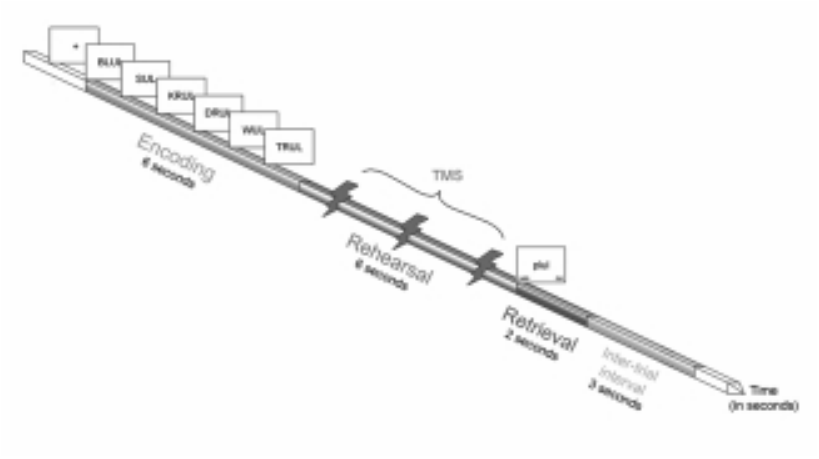
Fig. 2. Schematic of a TMS trial, The Sternberg VWM paradigm [28] has three phases: encoding, maintenance and retrieval. During the encoding phase, subjects studied a list of 6 short phonologically similar (depicted here) or phonologically dissimilar pseudo-words presented at a rate of 1 item per second. During the rehearsal interval, three TMS stimulations were applied at 1, 3, and 5 seconds following the last stimulus. A probe item was then visually presented during the retrieval phase, followed by an inter-trial-interval. A focus mark indicated the start of each